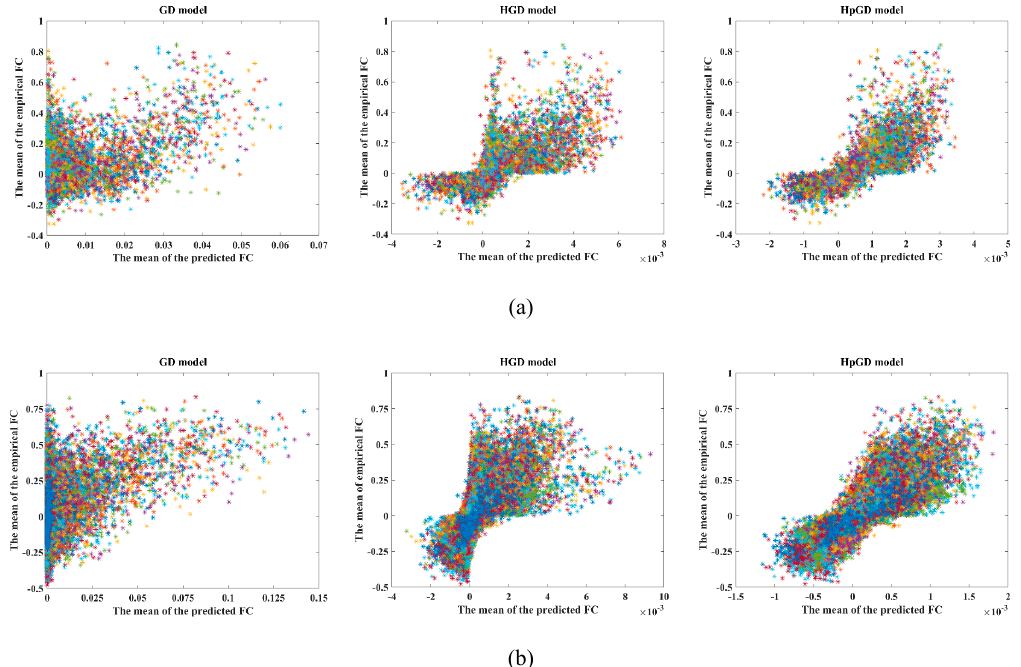
Figure 2. The scatter plots for the two datasets with the three models. ( a ) The 90 ROIs dataset. ( b ) The 246 ROIs Fig. 2 The scatter plots for the two datasets with the three models. (a) 90 ROIs dataset. (b) 246 ROIs dataset.